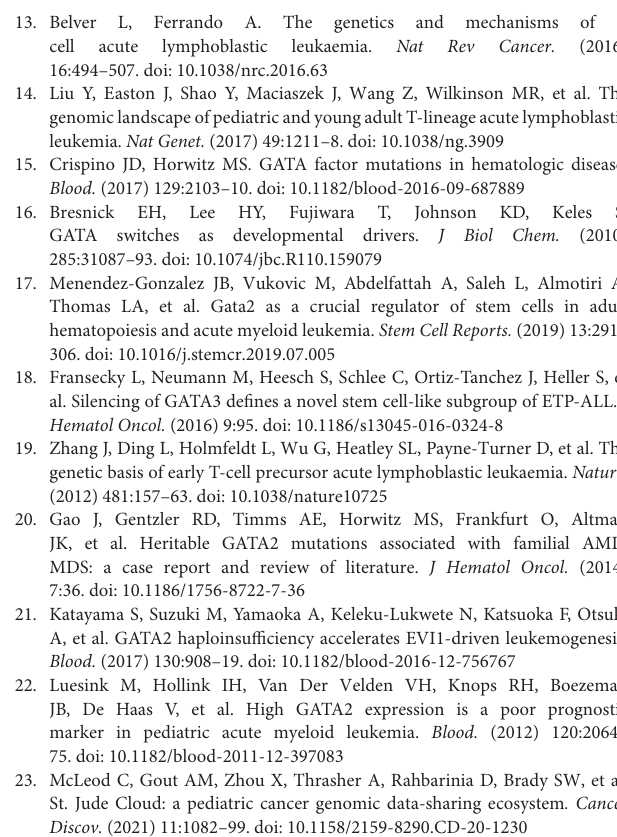
Supplementary Figure 1 | The effect of GATA2 activation on differentially expressed genes in B-ALL. (A) Intersection between down-regulated DEGs (left) and B cell markers (right). Three out of five B cell markers were down regulated in GATA2 -outlier cases and listed below. (B) A total of 451 down-regulated DEGs